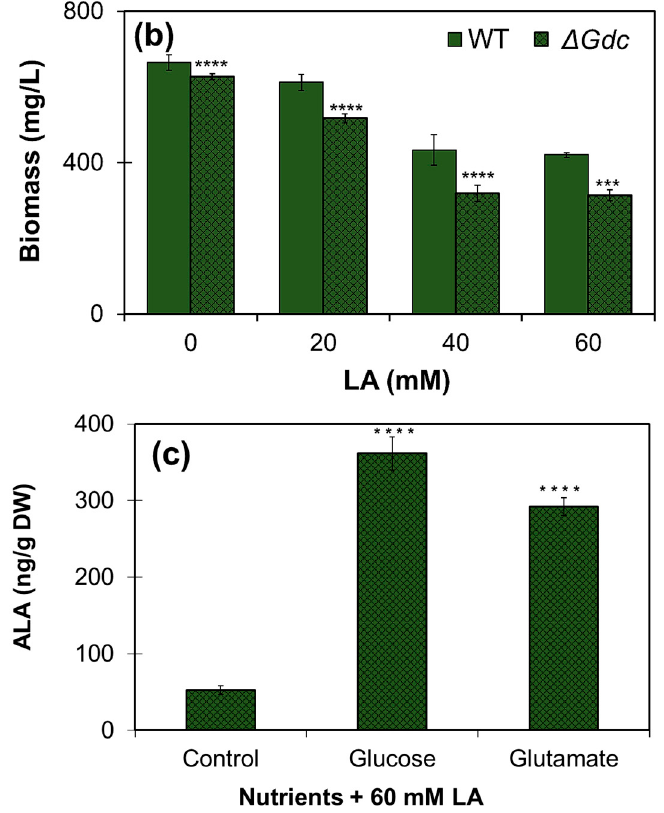
Figure 6. Quantification of the δ -aminolevulinic acid (ALA) production under a levulinic acid (LA) supply in the wild-type (WT) and the mutant Δ Gdc strains of Synechocystis . Effects of LA on ( a ) ALA production and ( b ) on the growth of cultures (biomass levels) in WT and Δ Gdc Synechocystis strains. Strains were grown until they reached the late-log phase, followed by a 48 h LA supplementation at the indicated concentrations. Results represent the mean ± standard deviation (SD) of experiments conducted in triplicate ( n = 3). The differences between means of the individual groups were analysed using one-way analysis of variance (ANOVA) via GraphPad Prism 9.3.1 software (San Diego, CA, USA). * p < 0.05, ** p < 0.01 *** p < 0.005, **** p < 0.001 versus WT group. ( c ) Effect of the supplementation of various nutrients (10 mM of glucose and glutamate) in addition to 60 mM LA on ALA production in Δ Gdc strain cultures. The mutant strain was grown until the late-log phase and was subsequently supplied with LA + glucose or glutamate for 48 h. A culture growing without the supplemented nutrients but with the addition of LA, which was used as a control. Results represent the mean ± standard deviation (SD) of experiments conducted in triplicate ( n = 3). The differences between means of the individual groups were analysed using one-way analysis of variance (ANOVA) via GraphPad Prism 9.3.1 software (San Diego, CA, USA). **** p < 0.001 versus control group. Table 2. Production of ALA by photosynthetic microbes.